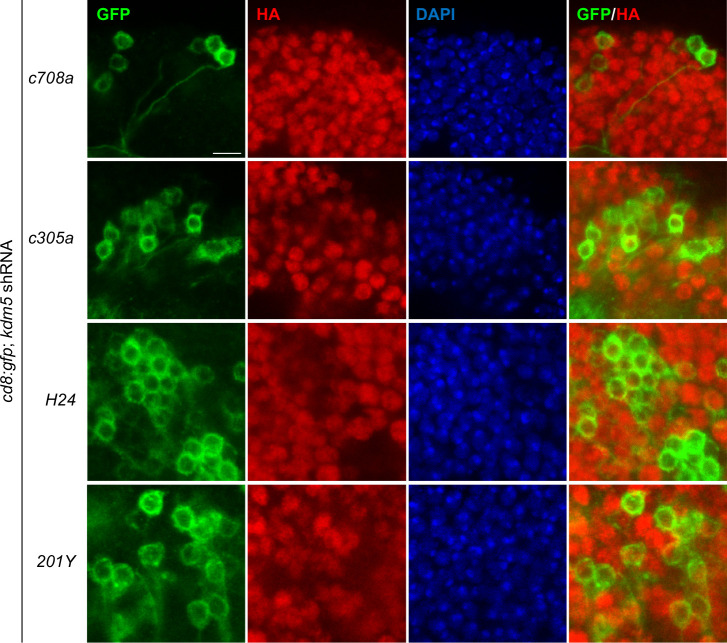
Validation of kdm5 knockdown within subpopulations of mature mushroom body (MB) neurons.MB Gal4 drivers promoting the expression of CD8:GFP to reveal shRNA-mediated lysine demethylase 5 (KDM5):HA depletion within subpopulations of mature Kenyon cells within the adult brain. Scale bar represents 5 μM.